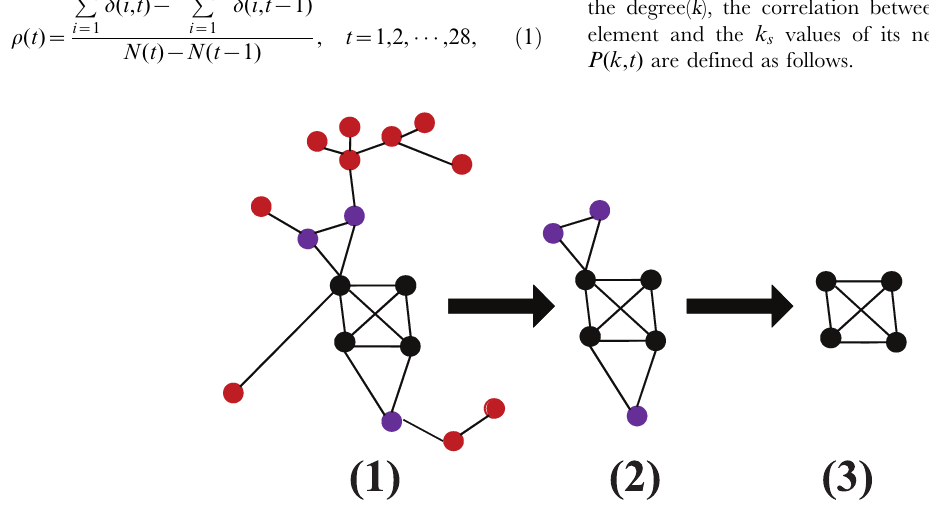
Figure 1. (Color online) Illustration of k -core decomposition. (1) is 1-core, (2) is 2-core, (3) is 3-core, i.e. core of the network.